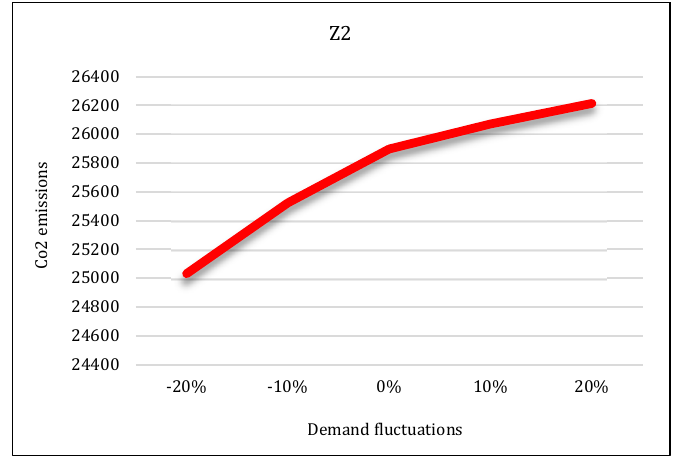
Figure 28. Demand variation effect on second objective function.